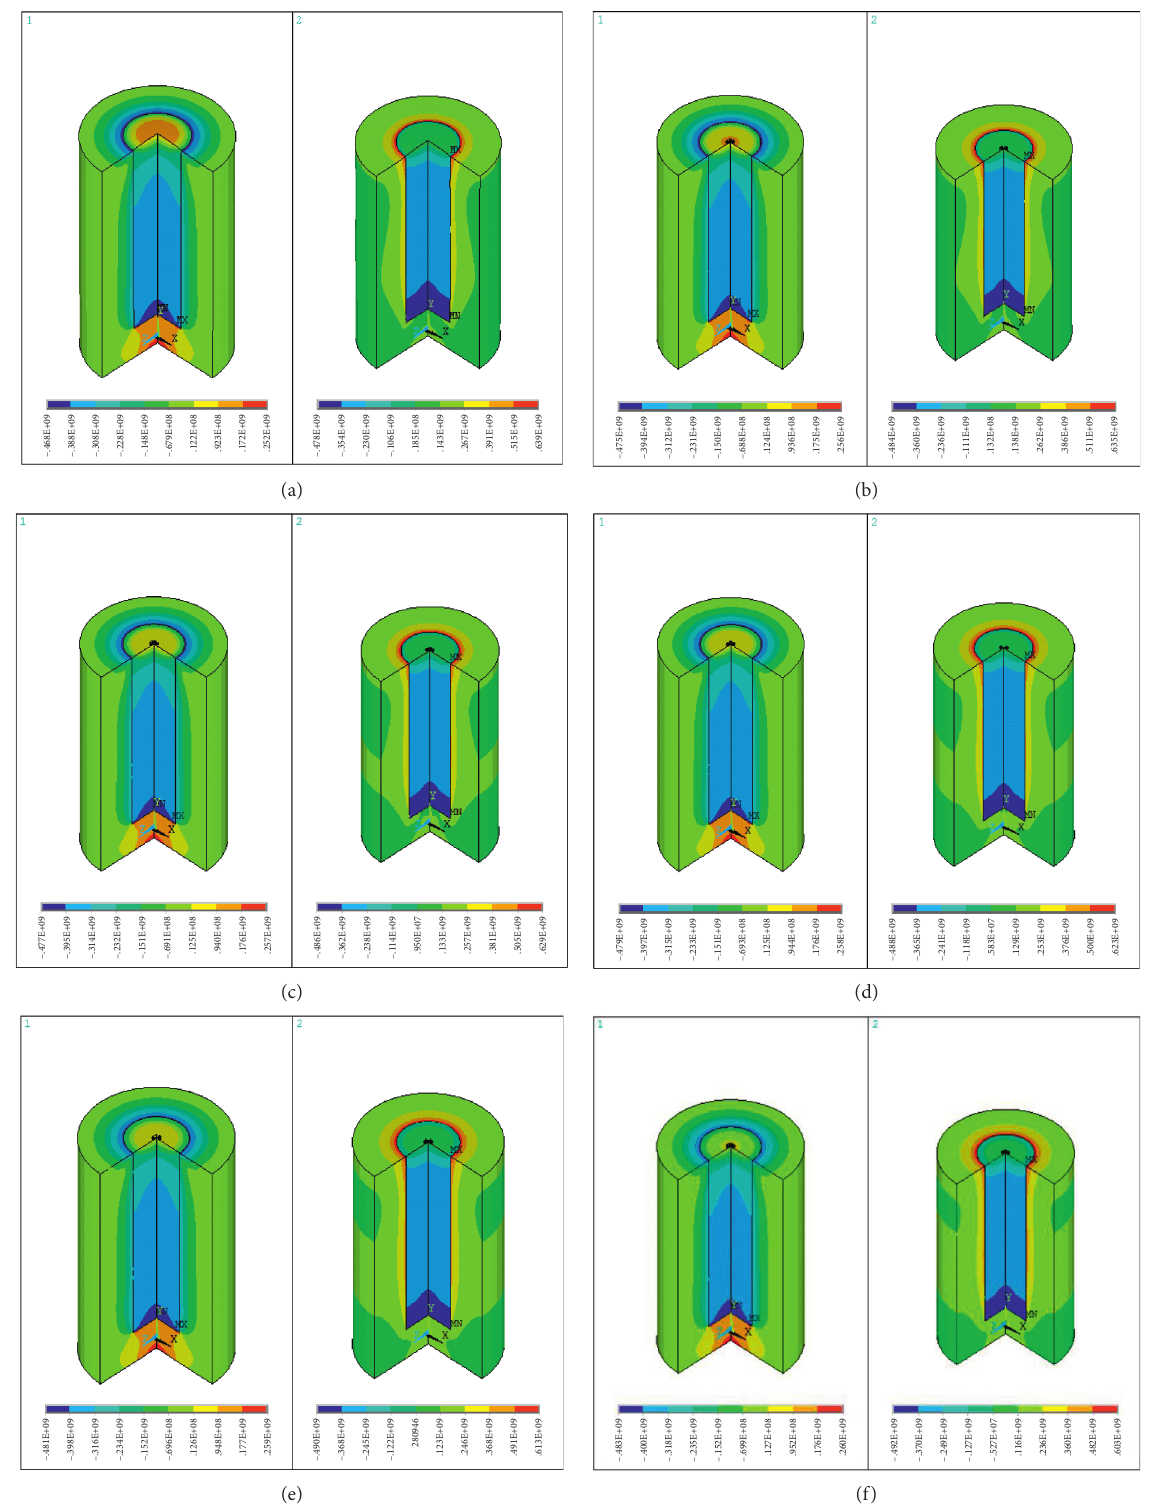
Figure 7: The radial and tangential stresses obtained with increasing squeeze pressures: (a) 0MPa; (b) 30MPa; (c) 50MPa; (d) 70 MPa; (e) 100MPa; (f)